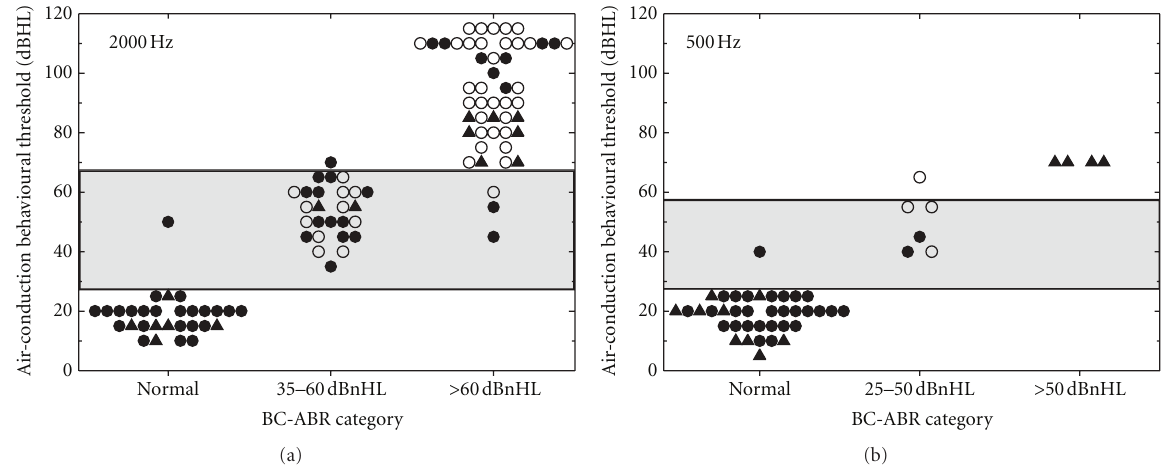
Figure 5: Comparison of BC-ABR threshold category to AC behavioural threshold data for 2000 Hz (a) and 500 Hz (b). Filled circles indicate ears with “certain” hearing status, whereas open circles indicate ears with “presumed SNHL.” Filled triangles represent ears where BC behavioural results were used (i.e., when AC behavioural results did not reflect cochlear status). Behavioural categories are indicated by horizontal lines/shading. See text for